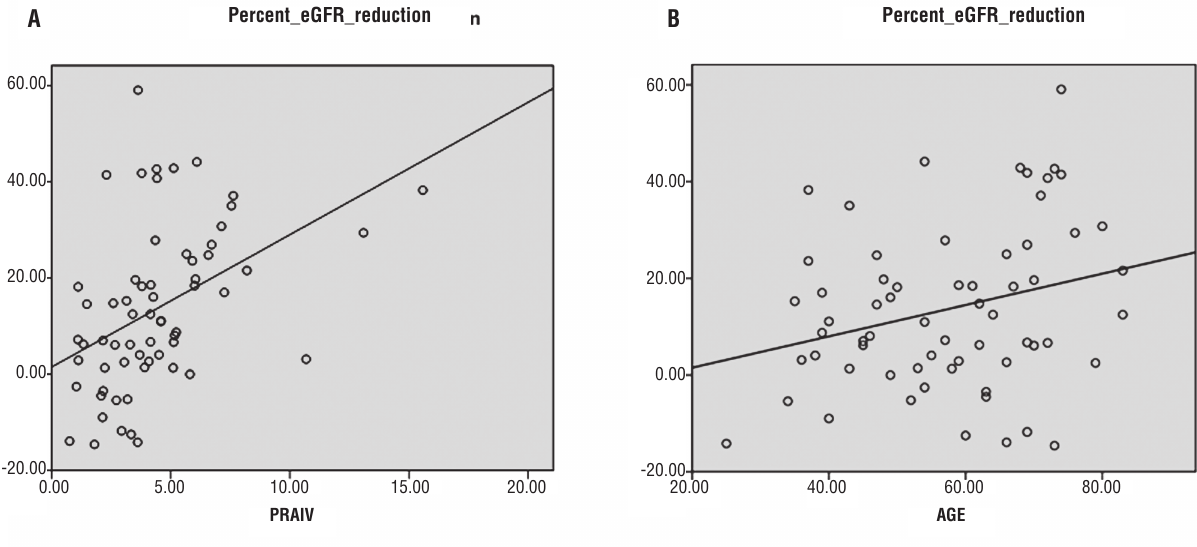
Figure 2 - Correlation plots of percent eGFR reduction with PRAIV and age. A, percent eGFR reduction vs. PRAIV, y=1.512